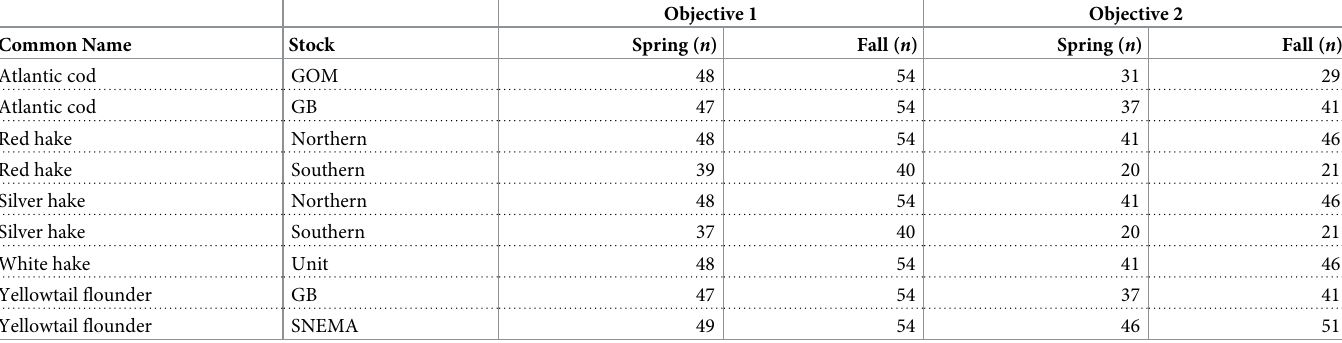
Table 2. Sample sizes ( n ) for objective 1 (time series analysis of spatial distribution) and objective 2 (relative importance of predictor variables on spatial